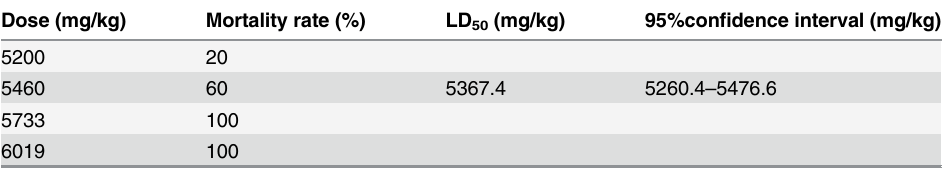
Table 1. The LD 50 and the 95% confidence limits of ATZ in mice (n =